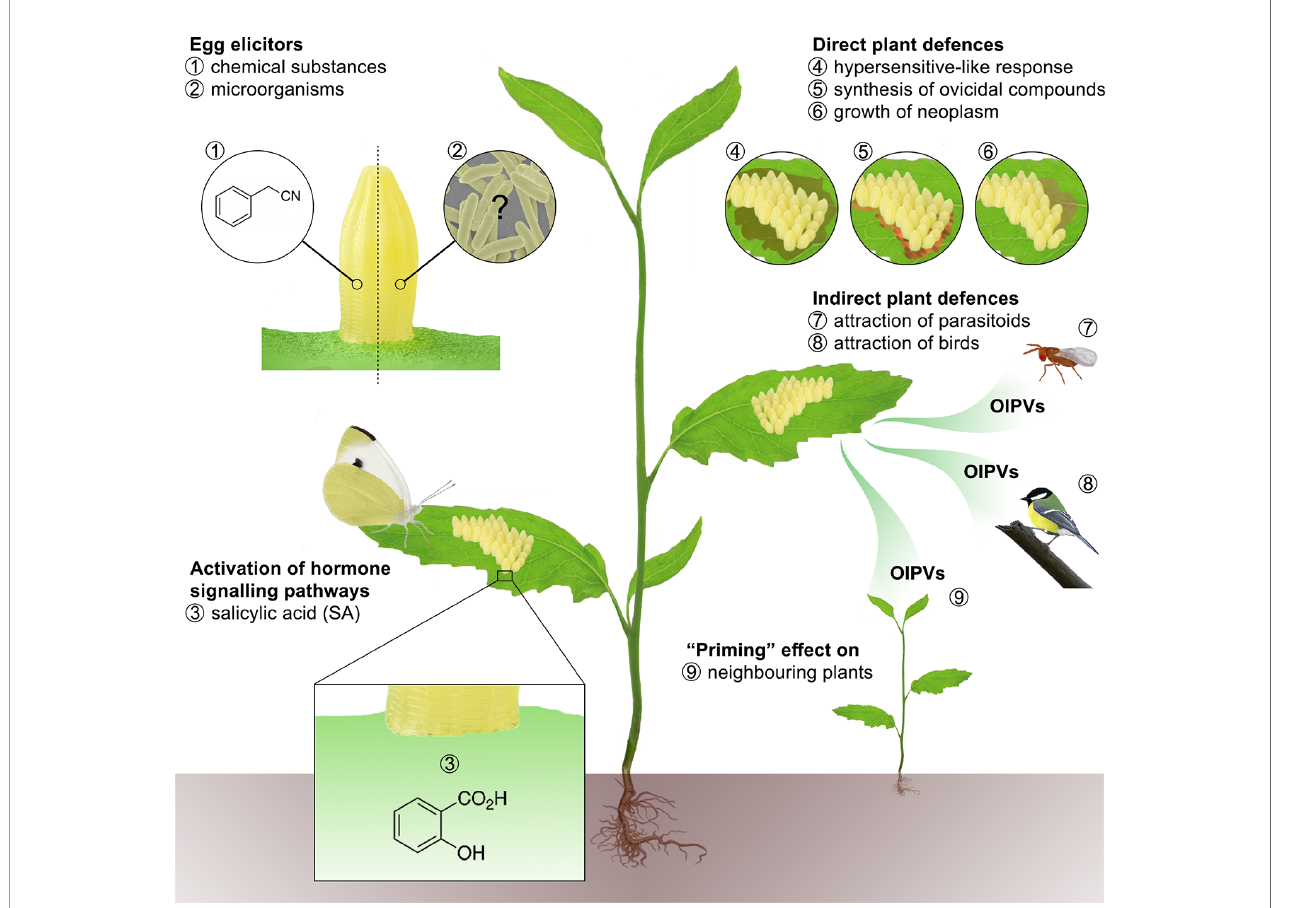
FIGURE 1 | Lepidopteran oviposition could represent a potential risk for host plants (Hilker and Fatouros, 2015), which can activate a pre-empted defense strategy to prevent or limit signi fi cant injuries. Therefore, plants have developed the ability to use egg deposition as a warning cue to increase defenses against larvae after hatching (Beyaert et al., 2011) or even modify their own phenology to achieve an early fl owering and reproduction (Lucas-Barbosa et al., 2013). Indeed, there is a bulk of evidence on the existence of speci fi c plant responses that may endeavor to damage eggs directly or indirectly. Egg elicitors, i.e. 1) chemical substances present on the egg surface (e.g. benzyl cyanide), and possibly 2) egg-associated microorganisms trigger downstream defense responses regulated through hormone signaling pathways of which 3) salicylic acid (SA) plays a pivotal role (Hil fi ker et al., 2014). Direct defense strategies include 4) necrotic tissue (HR-like necrosis), 5) ovicidal compounds (H 2 O 2 ) (Geuss et al., 2017) or 6) callose formation. Lepidopteran egg elicitors can also induce the production of oviposition-induced plant volatiles (OIPVs) enabling the plants 7) to attract egg or larval parasitoids, that upon locating their hosts, inject their own eggs and kill the lepidopteran instars to feed their off-spring (Tamiru et al., 2011; Fatouros et al., 2012; Cusumano et al., 2015; Ponzio et al., 2016) or 8) insectivorous birds (Mrazova et al., 2019). In addition, OIPVs can also prime 9) neighboring plants (Mutyambai et al., 2016; Guo et al.,